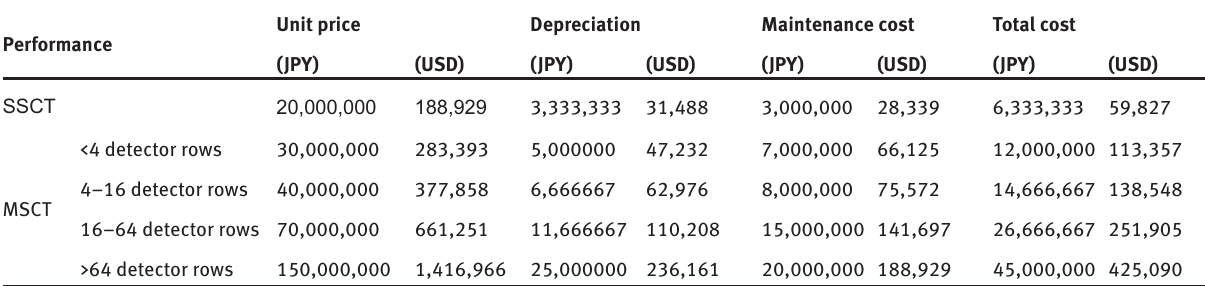
Table 1: Computed tomography (CT) cost model